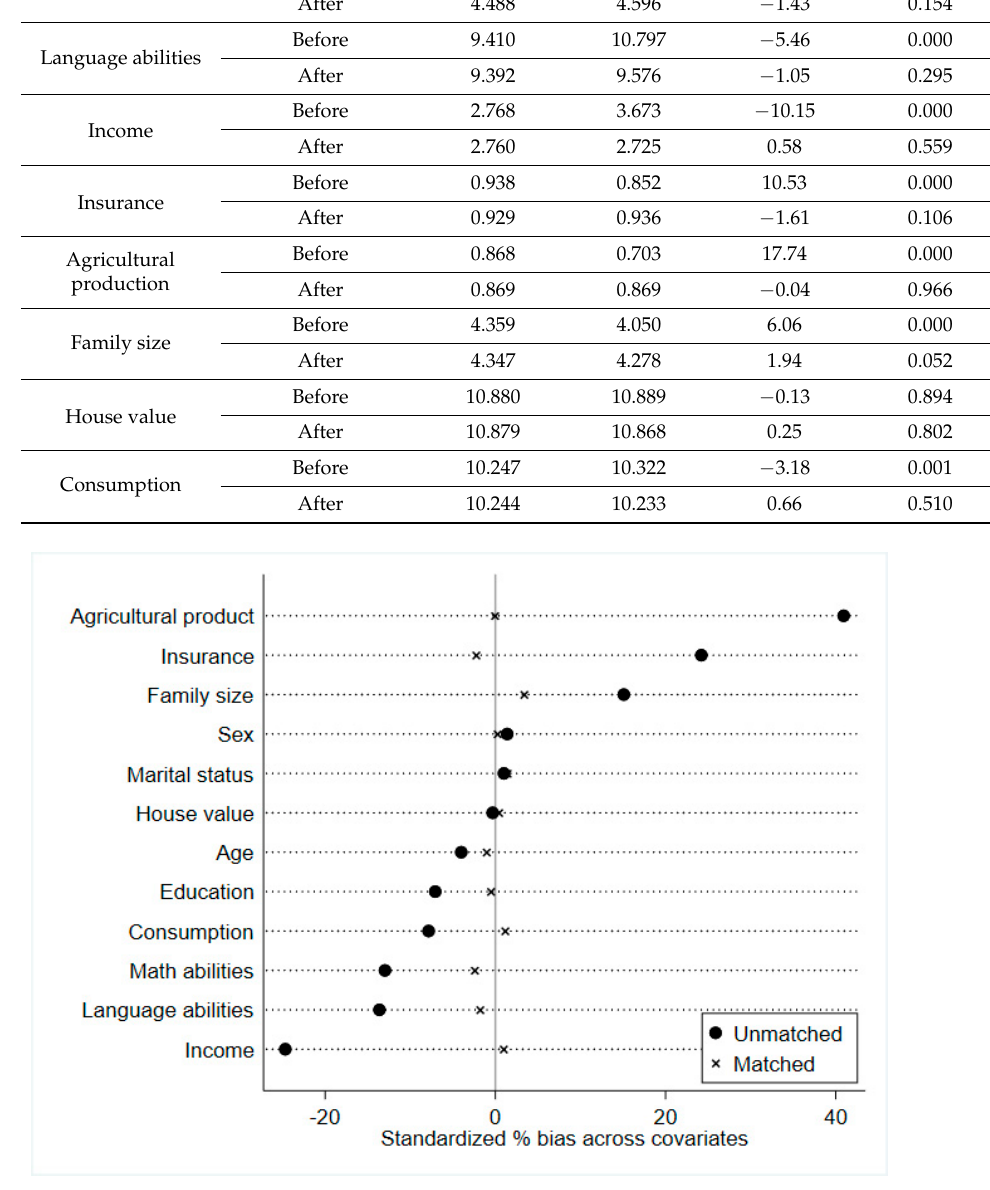
Figure 2. Standardized bias before and after matching.